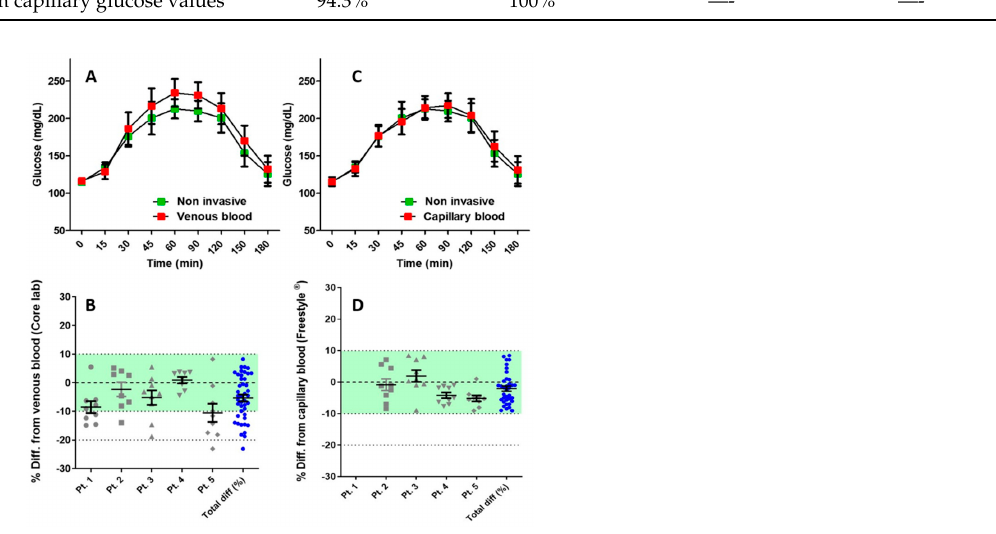
Figure 2. ( A ) Comparison of oral glucose tolerance test (oGTT) results between capillary blood (red) and HGR glucose readings (green). ( B ) Percentage difference of HGR glucose readings versus glucose levels of venous blood measured by the reference laboratory for each subject, and the full cohort. ( C ) Comparison of oGTT results: Abbott FreeStyle ® (red) and HGR (green). ( D ) Percentage difference of HGR readings versus capillary blood readings by Abbott FreeStyle ® glucose meters for each subject and the full